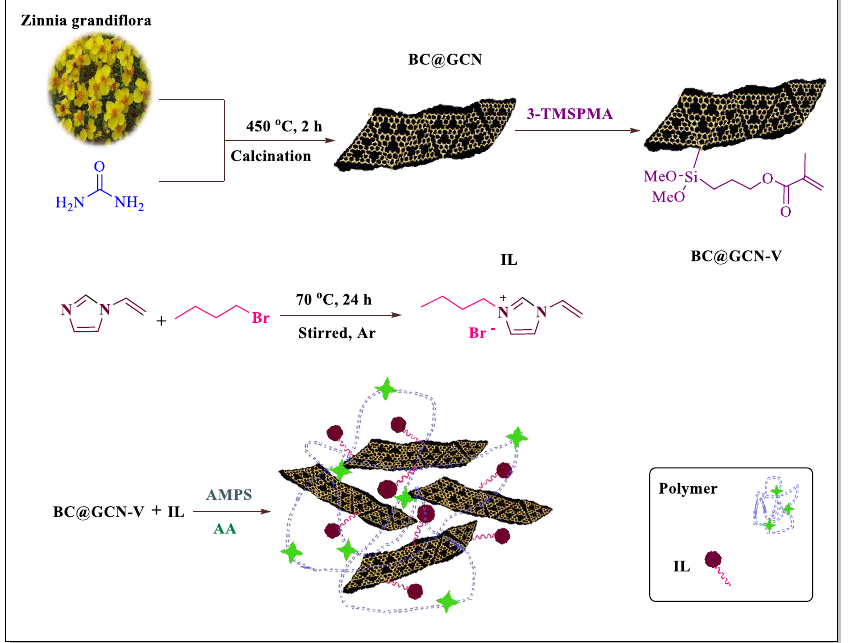
Figure 1. Schematic illustration of preparation of BC@GCN-P-IL.